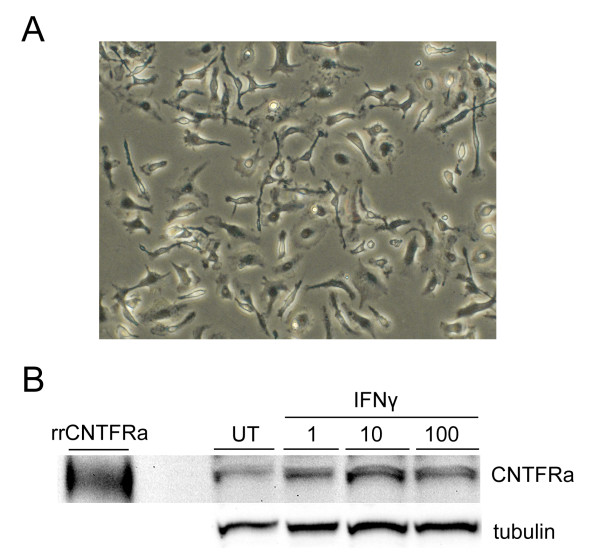
Murine microglia express CNTFRα, which is induced further by IFNγ. Panel A shows a representative photograph of cultured murine microglia. Panel B shows representative western blots for CNTFRα proteins in murine microglial cultures induced by IFNγ. Microglia were treated with IFNγ 1, 10 and 100 ng/mL, or left untouched for 22 hours. Forty micrograms of protein lysates were analyzed by western blotting. Membranes were probed with CNTFRα antibody and were re-probed with β-tubulin antibody to confirm equivalent protein loading. Recombinant rat soluble CNTFRα was loaded as a positive control (leftmost lane).